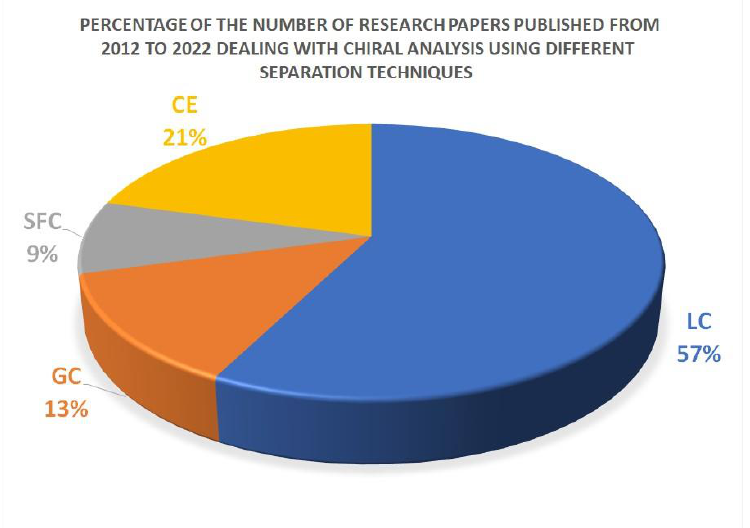
Figure 2. Percentage of research articles published from 2012 to 2022 (total number of articles 3230) dealing with chiral analysis utilizing various separation techniques, according to the Web of Science Reuters Clarivate Analytics database (Accessed 20 July 2022) (LC; liquid chromatography, CE; capillary electrophoresis, GC; gas chromatography, SFC; supercritical fluid